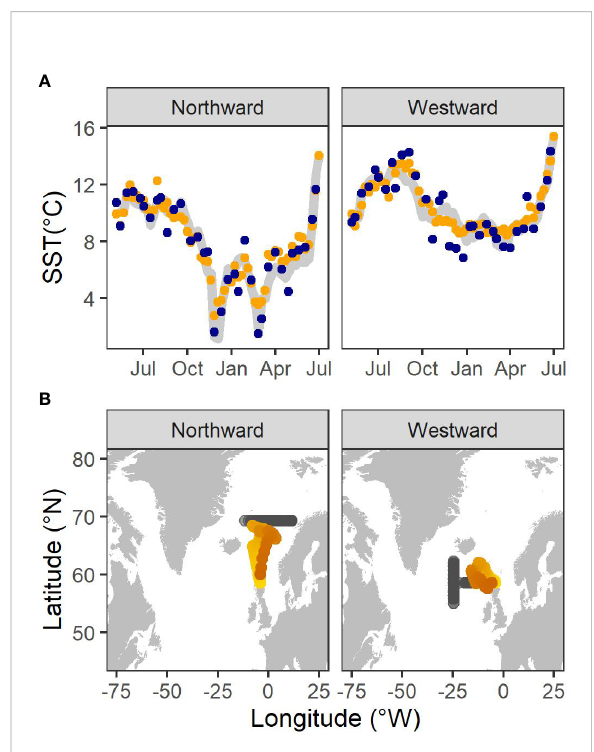
FIGURE 1 (A) SST values sampled from a normal distribution centered on SST values extracted from the true simulated location (grey line) with s = 1°C (blue points), thinned to the SIMS sampling frequency of a 1SW fi sh and used as data in the hidden Markov Model to infer locations. SST values extracted from the mean inferred location (orange points) also are presented. (B) The mean locations (orange points) inferred from the hidden Markov model together with the true simulated locations (grey points) for each simulation. Lighter colour indicates the beginning of the